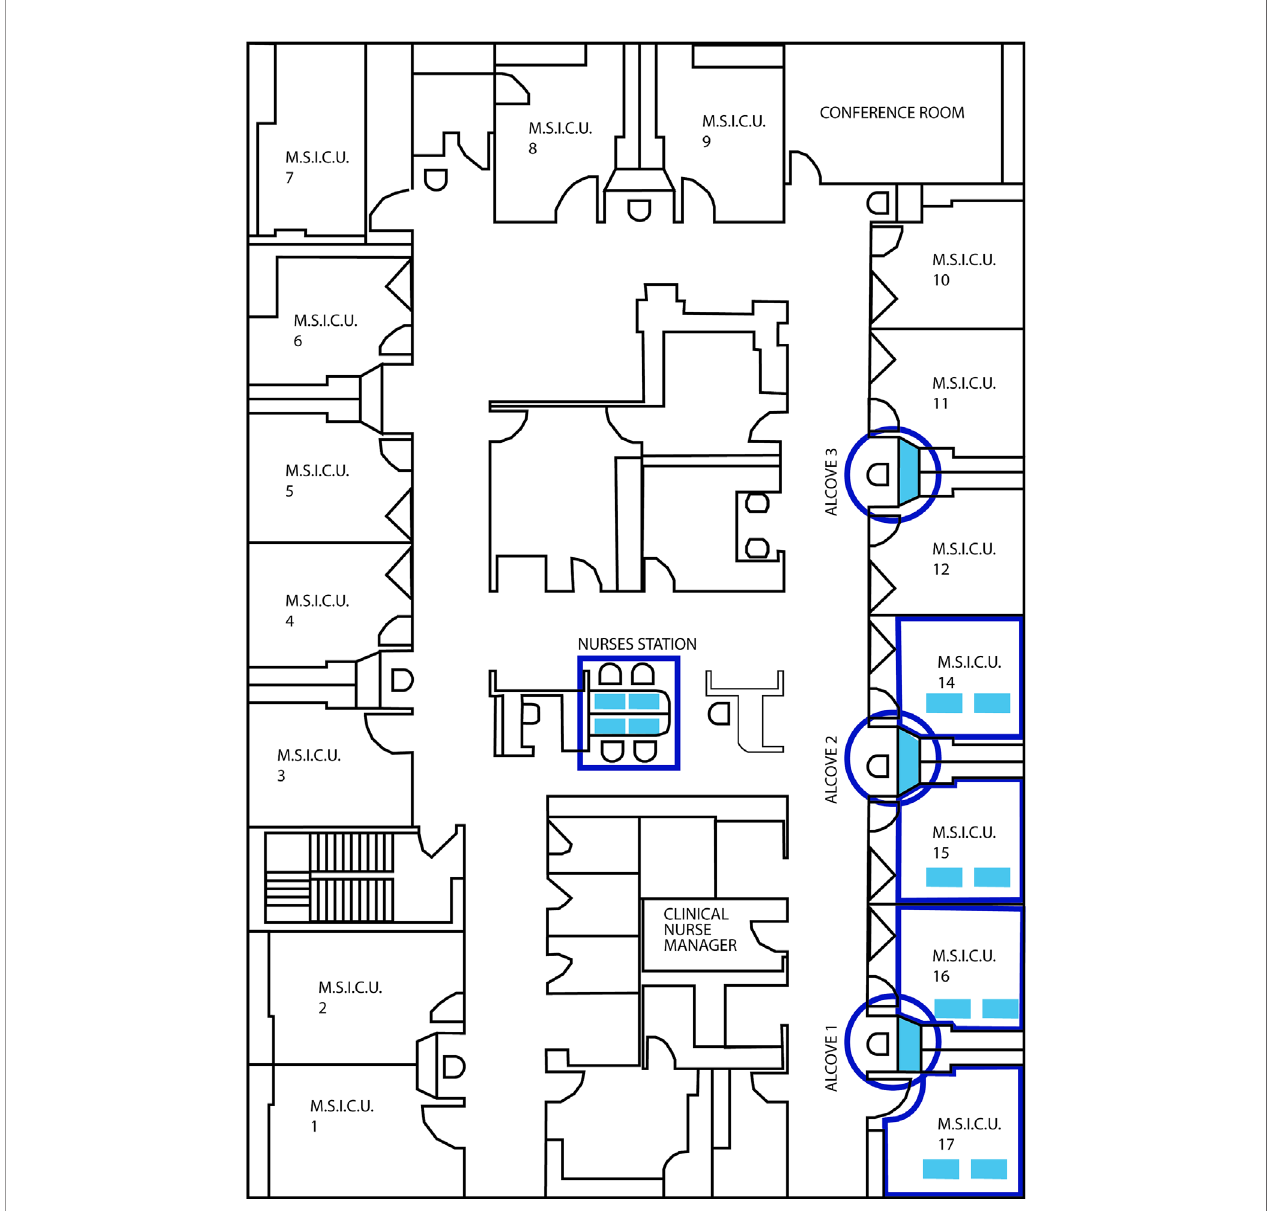
FIGURE 1 | Detailed blueprint of the ICU layout illustrating the location of the 4 patient rooms, 3 nurse ’ s alcoves (circles) and central nurses station samples during the